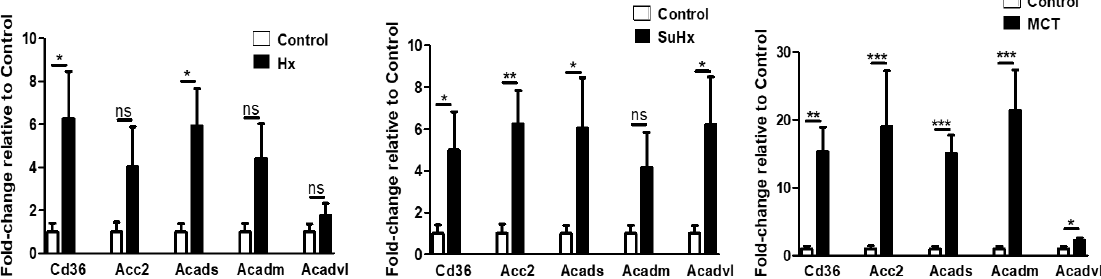
Figure 8. Altered adipose tissue levels of fatty acid oxidation marker mRNA in experimental pulmonary hypertension. Data represent mean ± SEM from n = 8–14 animals per experimental group. Statistical analysis by Student’s t -test. * p < 0.05, ** p < 0.005, *** p < 0.001, ns: no significant.